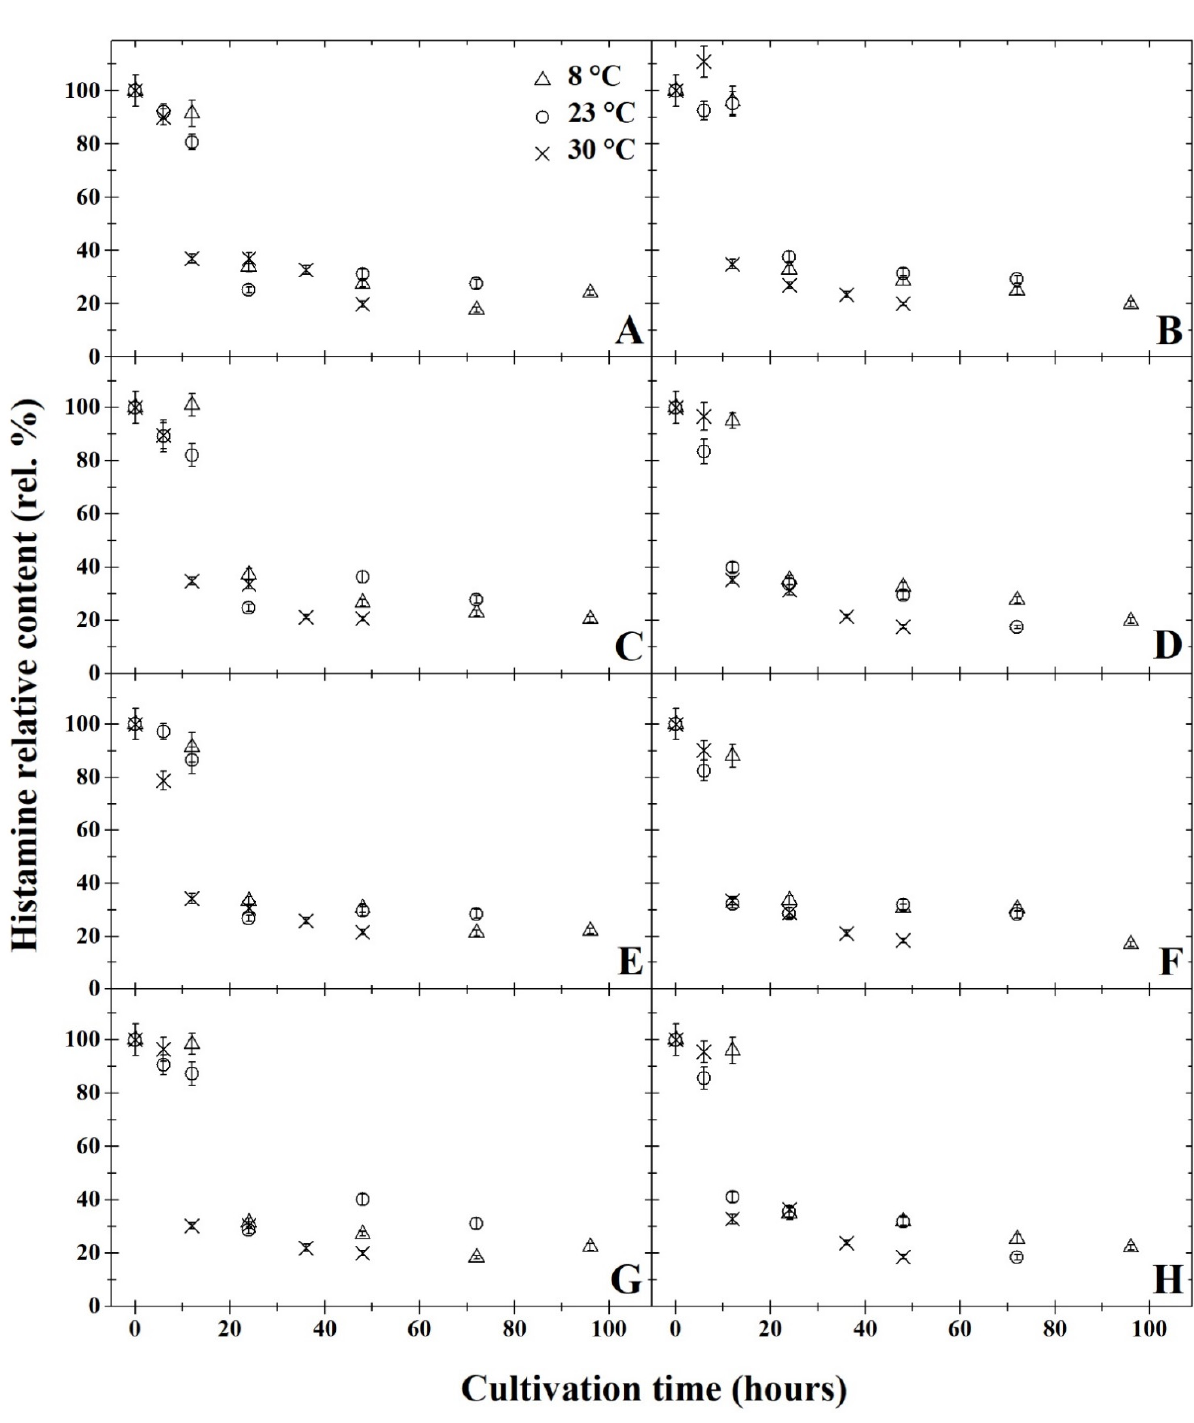
Figure 4. Development of histamine relative content (rel. %) by degradation using Bacillus subtilis DEPE IB1 in dependence on the cultivation time (hours); the initial histamine relative content at the time zero were always 100%. Parts ( A , C , E , G ) represent the results of anaerobic cultivation and parts ( B , D , F , H ) show the results of aerobic cultivation. Incubation was carried out under pH = 5 (parts A and B ), pH = 6 (parts C and D ), pH = 7 (parts E and F ), pH = 8 (parts G and H ). Three cultivation temperatures were used: 8 ◦ C ( (cid:52) ), 23 ◦ C ( ) and 30 ◦ C ( × ). The results were presented using the means and standard deviations (bars; n = 24).